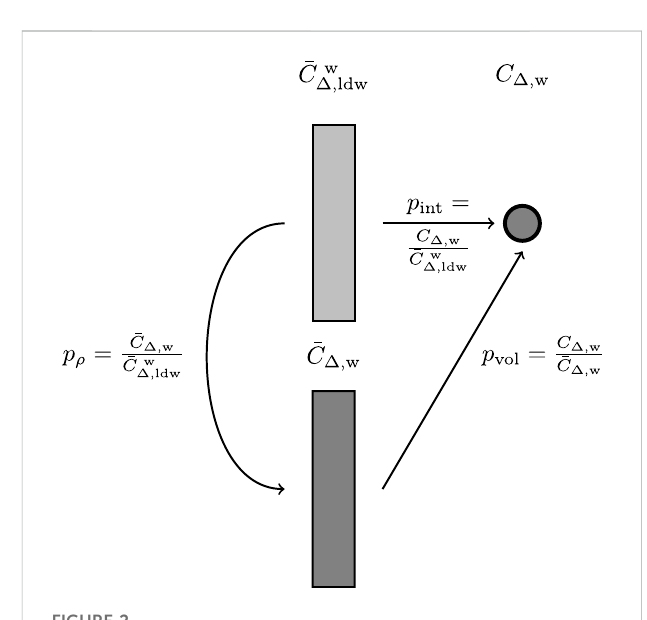
FIGURE 2 Schematicdescriptionofthedeterminationofcema-basedinternal fl uence correction factors for air- fi lled ionization chambers following [19, 20]. The internal fl uence correction factor p int includes the volume- averaging effect p vol and the density effect p ρ . The acronym ldw refers to the virtual medium “ low-density water ” . Note that (cid:1) C Δ , w is determined without the shift of the EPOM